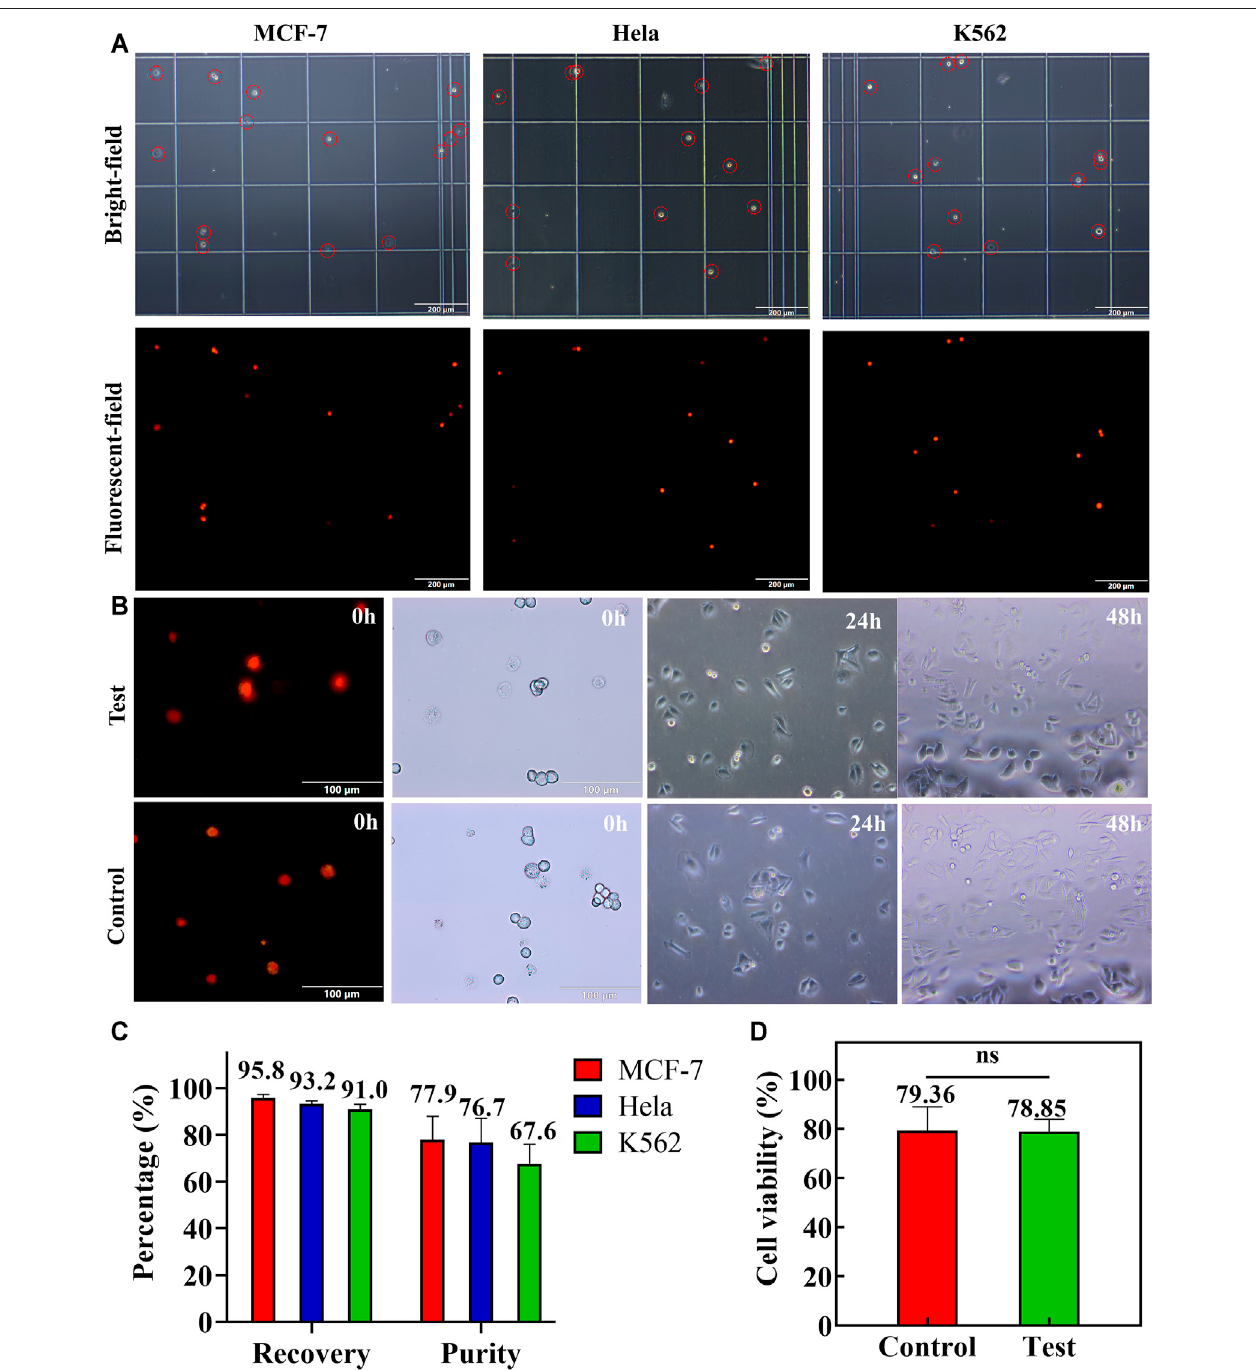
FIGURE 5 | Spiked MCF-7, HeLa, and K562 cells were applied to test the double spiral microchannel. (A) Microscopic bright fi eld (red circle marked tumor cells) and fl uorescence images of MCF-7, HeLa, and K562 collected from the target outlet. The scale bar is 200 μ m. (B) Short-and long-term cell activity tests. Colored cells areapoptoticcellsordeadcells.Thescalebaris100 μ m. (C) Recoveryandpurityofthreecellsinthetargetoutlet. (D) Comparisonoftheshort-termcellviabilitybetween the test and control groups. Ns: p > 0.05.